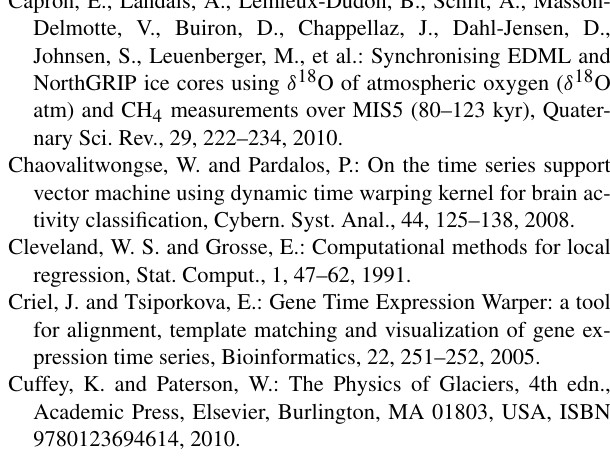
m9.figshare.14946177.v1 (Martins and Travassos, 2021). The per- oxide concentration data can be requested from Mariusz Potocki